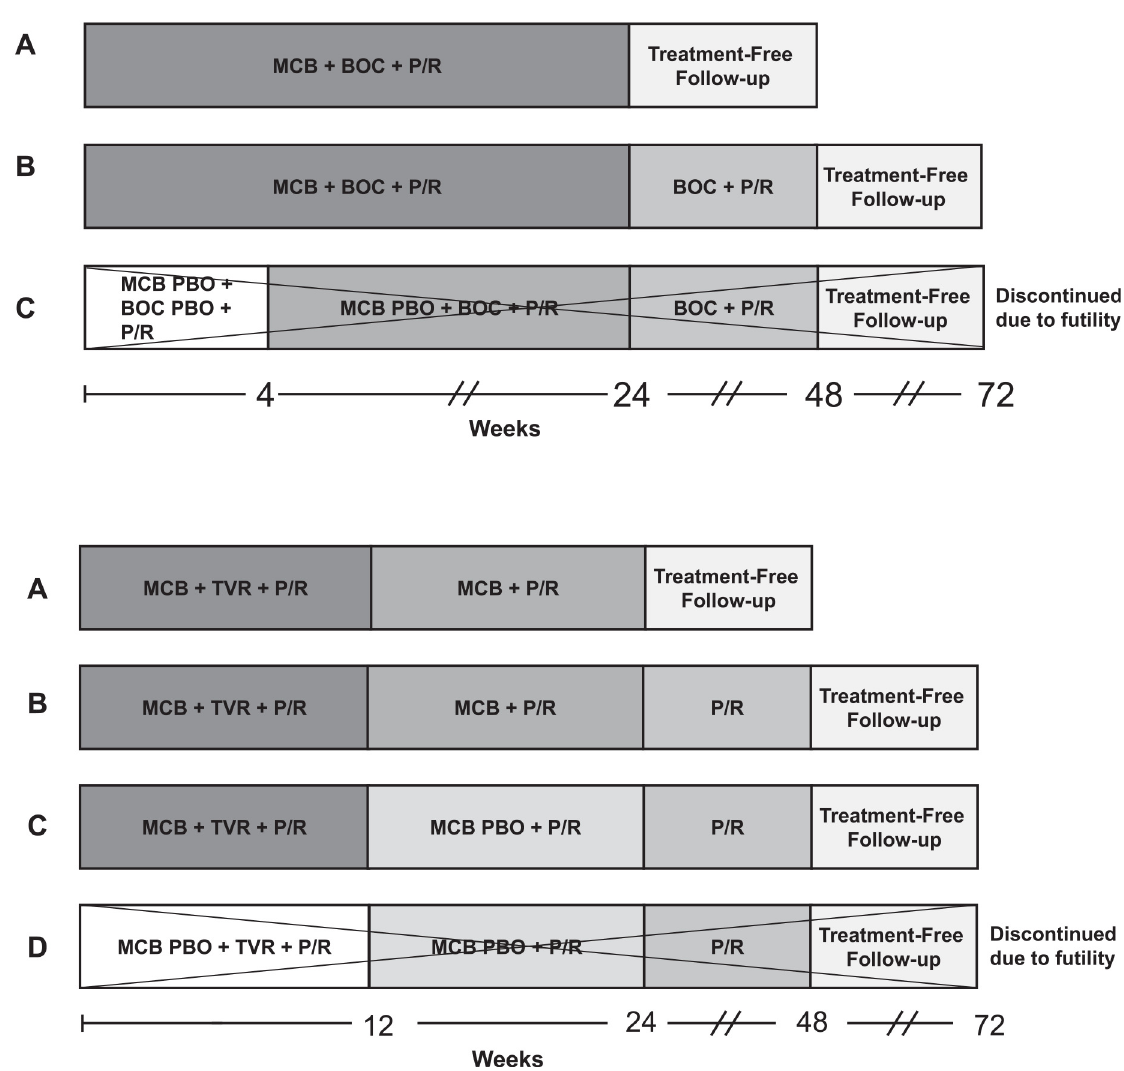
Fig 3. Study designs of DYNAMO 1 (a) and DYNAMO 2 (b). BOC, boceprevir 800 mg TID (at recommended intervals of 7 – 9 hours); MCB, mericitabine 1000 mg BID; P/R, peginterferon alfa-2a 180 μ g once/week + ribavirin 1000 mg/day ( < 75 kg) or 1200 mg/day ( (cid:1) 75 kg); PBO, placebo; TVR, telaprevir 750 mg TID (at recommended intervals of 7 – 9 hours). Control Arms C in DYNAMO 1 and D in DYNAMO 2 were closed due to futility while the studies were ongoing (27 July 2012 in DYNAMO 1 and 10 July 2012 in DYNAMO 2), after which patients in these groups were given the option to receive mericitabine for a maximum duration of 24 weeks. MCB was added to the regimen for 5 patients in Arm C in DYNAMO 1 and to the regimen for 9 patients in Arm D in DYNAMO 2 at various time points and for various